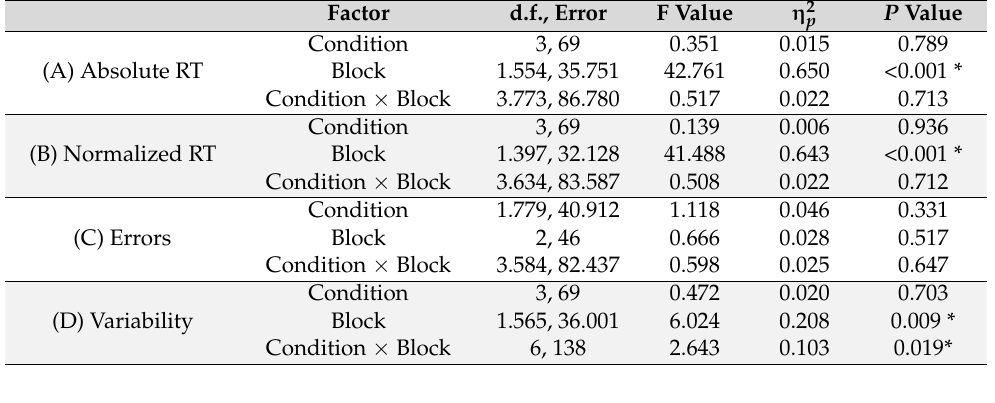
Table 2. Effect of tDCS on R-SRTT. Results of the mixed-model ANOVAs conducted for R-SRTT: (A) absolute RTs, (B) normalized RTs, (C) number of errors, and (D) variability of absolute RTs. Asterisks indicate significant results ( p < 0.05). d.f. = degrees of freedom, η 2 p = partial eta squared.